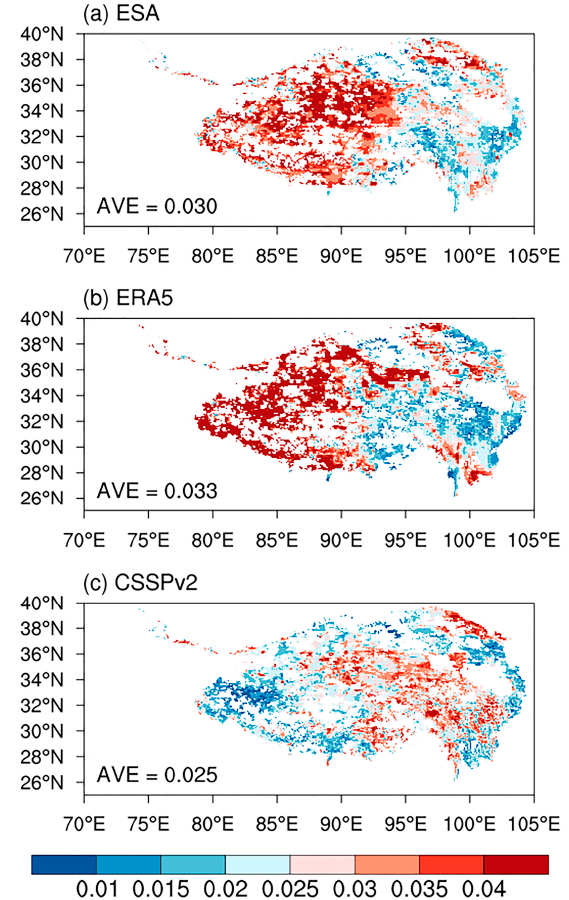
Figure 7. Spatial distributions of the error standard deviation of ( a ) ESA, ( b ) ERA5, and ( c ) CSSPv2 products in the study area. AVE stands for spatial average.